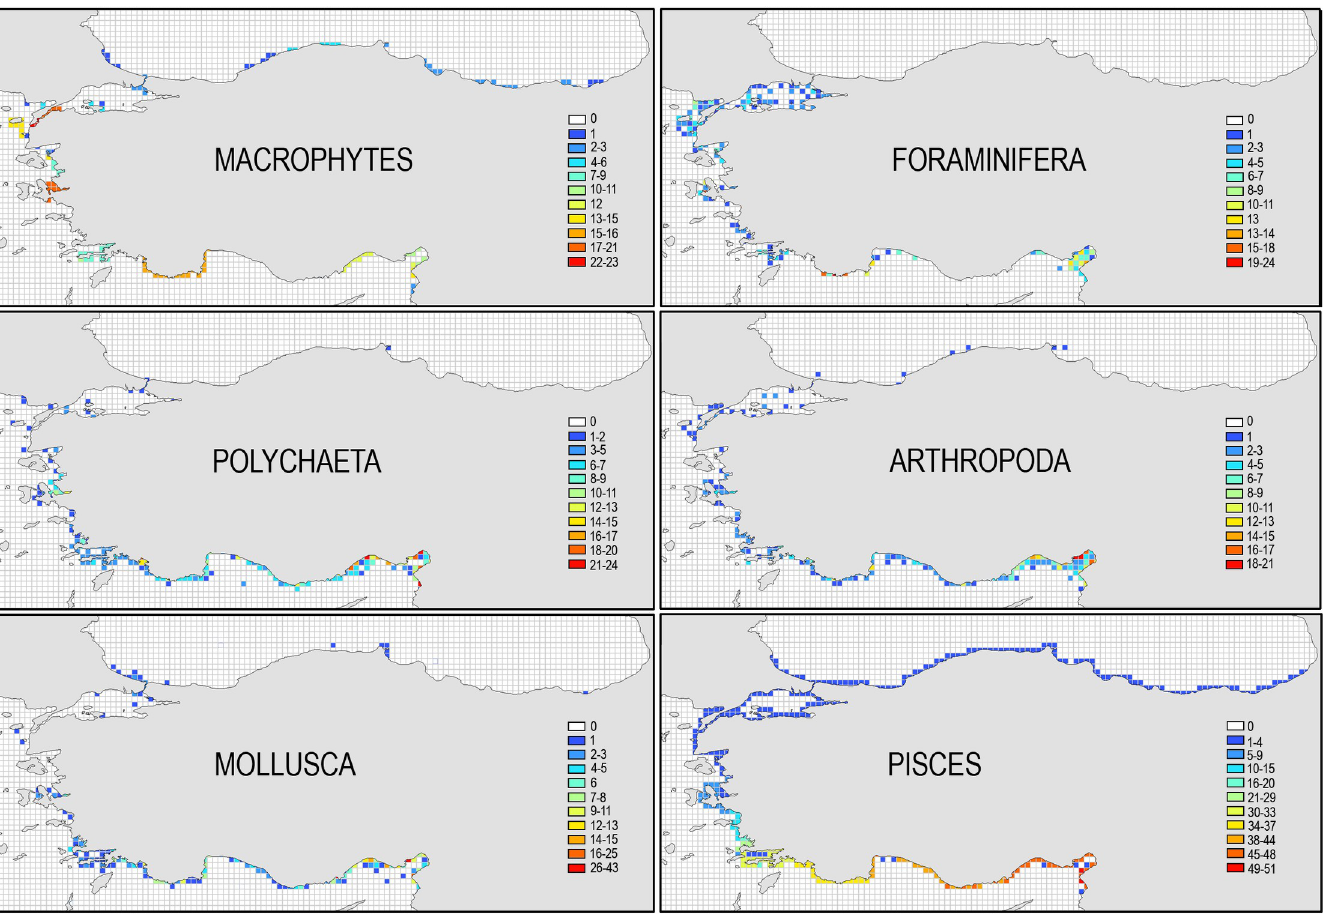
Fig 5. The number of alien species belonging to major groups found in grids of 15x15 km along the coasts of